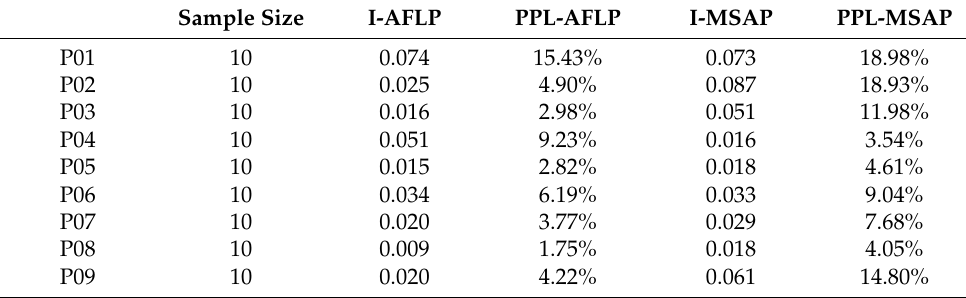
Table 2. Genetic and epigenetic diversity of the natural population of D.